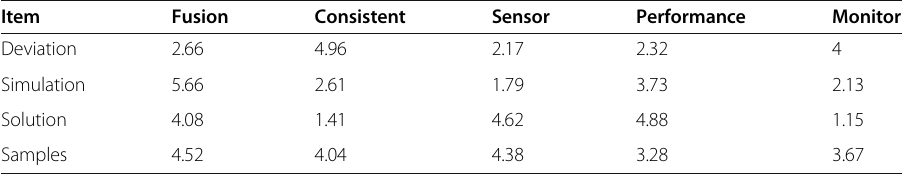
Table 5 The node sends the abnormal data to the host node Item Fusion Consistent Sensor Performance